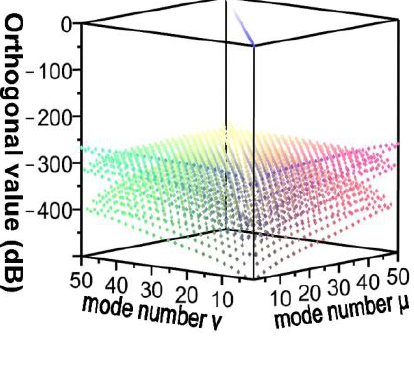
Figure 7. Plot of the orthogonal values for the 50 guided